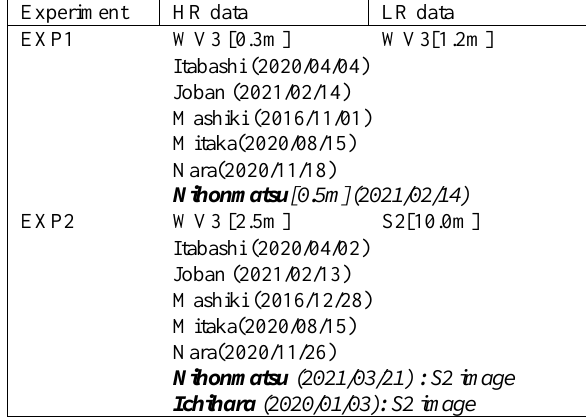
Table 1. Summary of the data sets used in respective experiment (image names written in bold italic corresponds to test data